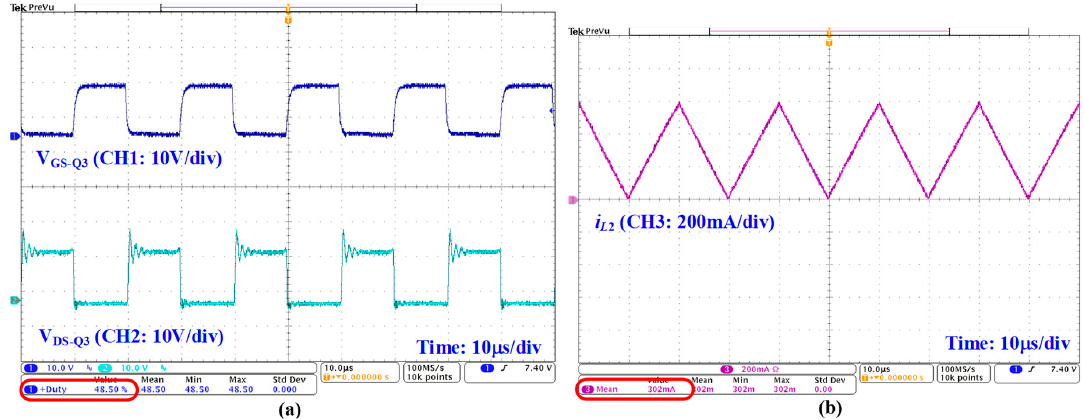
Figure 13. Measured waveforms of PCL 2 with the FDC method: ( a ) switch voltages of V GS-Q3 and V DS-Q3 , ( b ) inductor current of i L 2 .